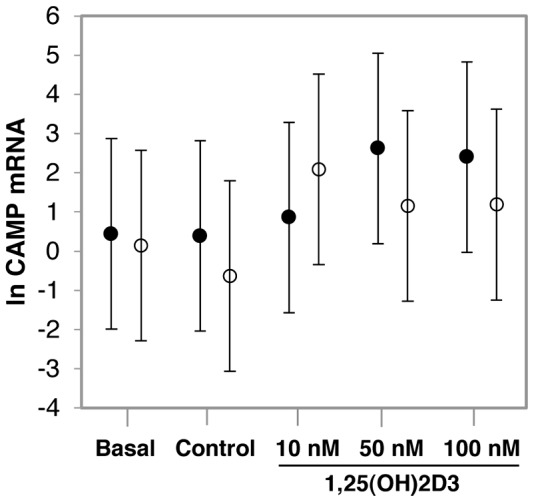
The impact of increasing in vitro 1,25(OH)2D3 supplementation on CAMP expression.Error-bar plots illustrate the mean level of CAMP expression. Data is differentiated by ethnicity: Africans (black, n = 4) and Whites (white, n = 4). Gene expression was quantified in monocyte-macrophages from healthy individuals using RT-qPCR before (basal) and after 24 h of in vitro 1,25(OH)2D3 supplementation at increasing concentrations (10 nM, 50 nM, and 100 nM). The trend for higher CAMP in Whites and lower CAMP in Africans at 10 nM, appears to be reversed at higher levels of 1,25(OH)2D3 supplementation (50 nM and 100 nM). Error bars display the LSD for each data set.